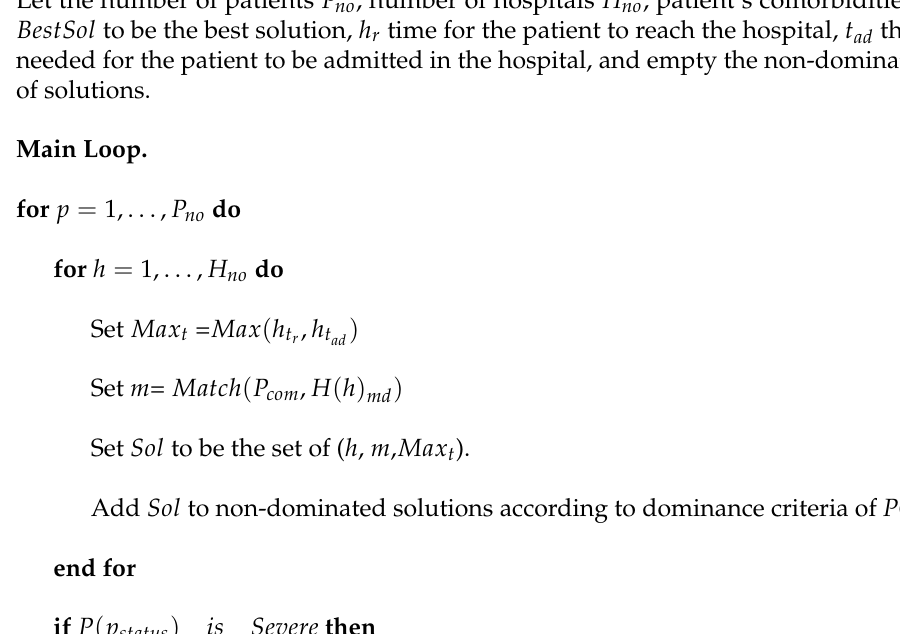
Algorithm 1 Pseudocode of Pareto optimization algorithm applied for the hospital